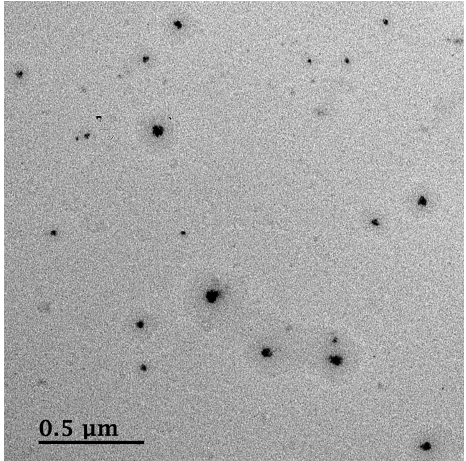
Figure 4. Field-emission transmission electron microscope (FE-TEM) image of methotrexate-loaded nanoemulsion (15% ( v / v ) for S mix , 2% ( v / v ) for W 1 , 8% ( v / v ) for O, 75% ( v / v ) for W 2 , 1:2 ratio ( w / v ) of methotrexate:oil, and three microfluidizer passes).